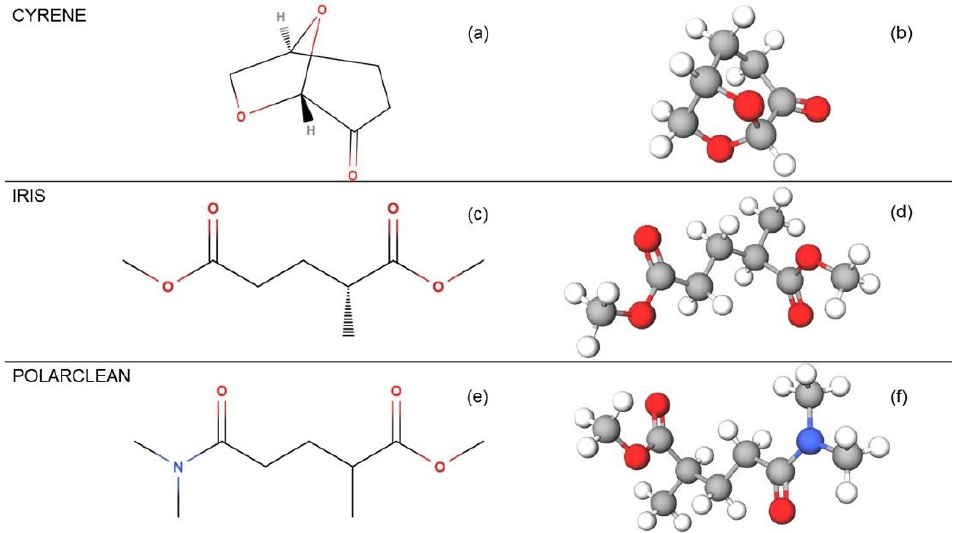
Figure 1. Comparison of the molecular structures of the solvents used: Cyrene, Iris, and Polarclean, whose atomic structures are shown in ( a , c , e ) plain and ( b , d , f ) ball-and-stick layouts, respectively.